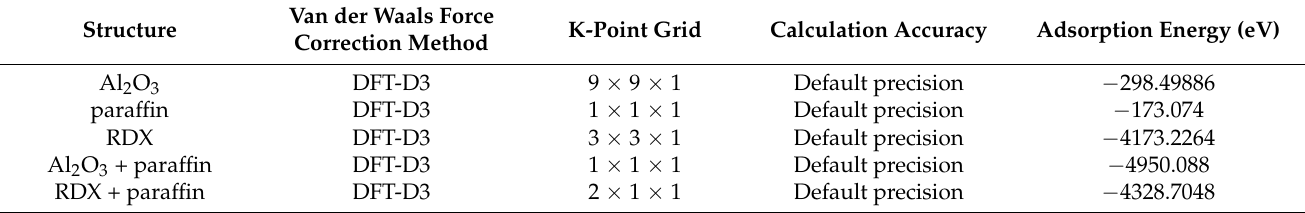
Table 7. Parameter setting and the corresponding calculated energy of each component.